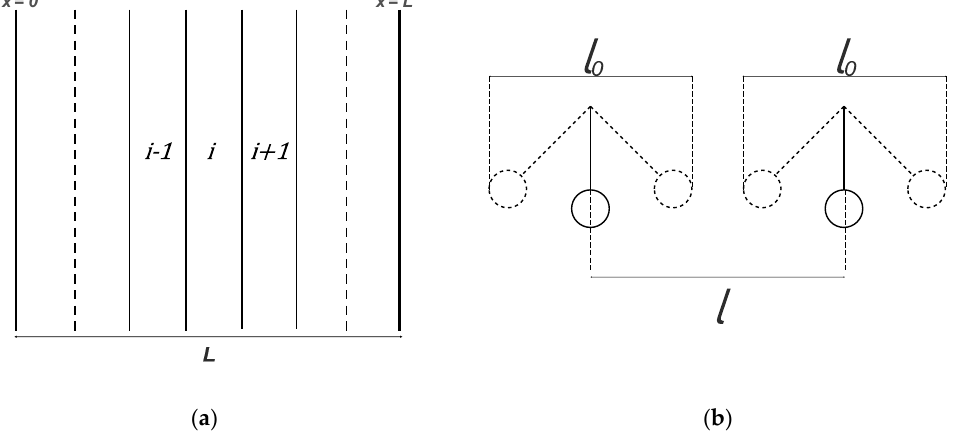
Figure 10. Representation of membrane thickness in Cussler et al. [100]. ( a ) Series arrangement of contiguous lamellae. L is the membrane thickness. ( b ) Contiguous fixed sites. l 0 is the oscillation width, l is the distance between equilibrium positions. For l > l 0 solute exchange between contiguous sites cannot occur.